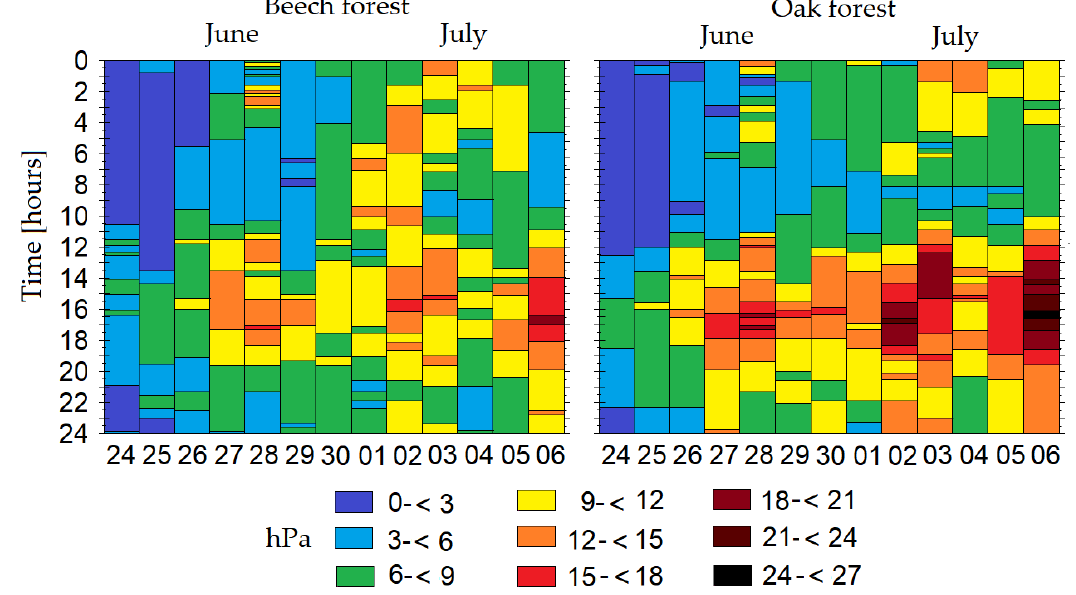
Figure 5. Diurnal variation in vpd on 13 days in summer 2019 (June 24—July 06) in the interior of the beech forest ( left ) and oak forest ( right ) of the Eşelniţa transect.